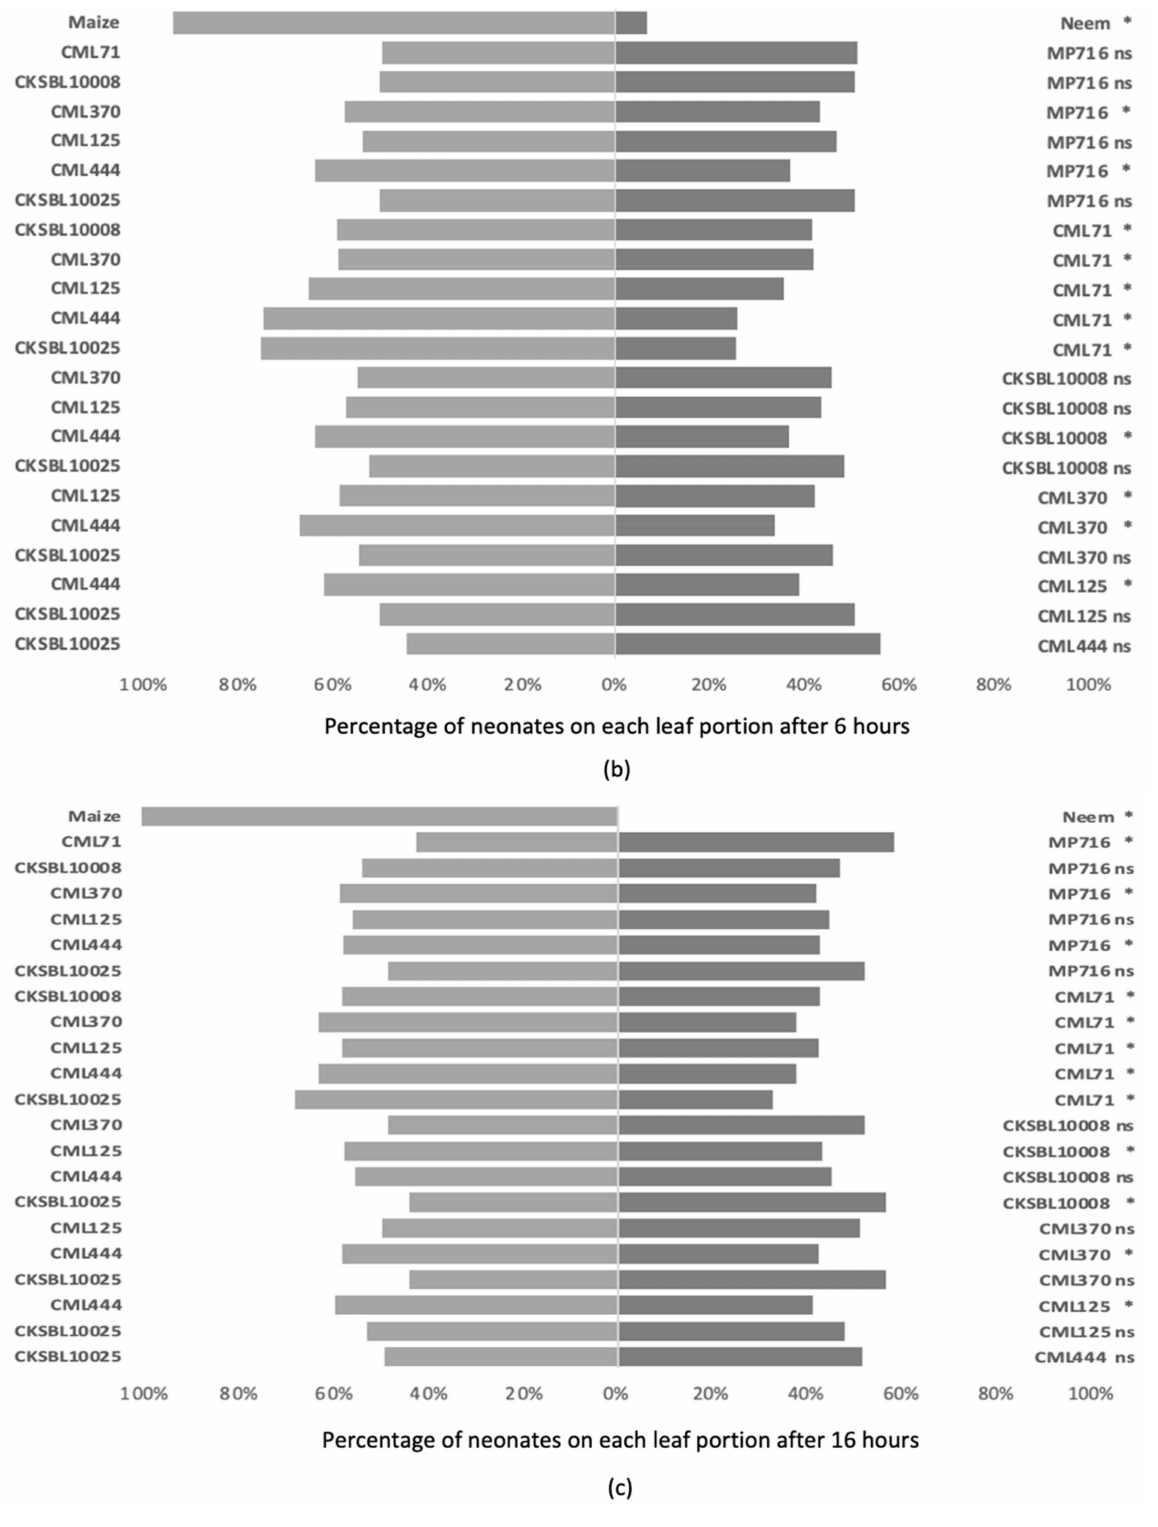
Figure 2. Mean percentage of Spodoptera frugiperda neonates found on leaf portions of each inbred line under binary choice conditions between inbred lines (n = 21) in a Petri dish after 1 ( a ), 6 ( b ) and 16 h ( c ) of bioassay. Asterisks (*) represent significant differences and (ns) represent no significant differences at 5% level (Wilcoxon rank sum